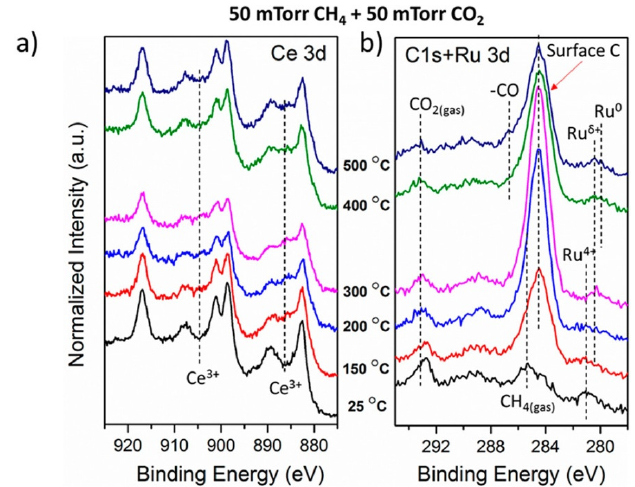
Figure 4. ( a ) Ce 3d and ( b ) C 1s + Ru 3d NAP-XPS spectra of the 0.5 wt % Ru(NC)–CeO 2 catalyst under ~ 0.13 mbar CH 4 / CO 2 (1:1). Reprinted with permission from [149], copyright 2019, American Chemical Society.